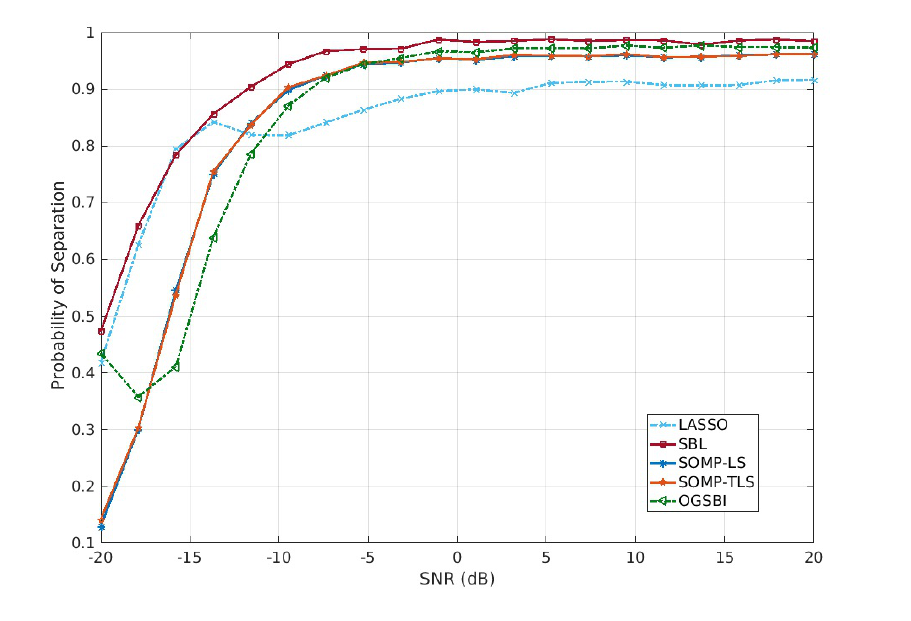
Figure 3. Separation probabilities vs. SNR with T = 200 based on coprime